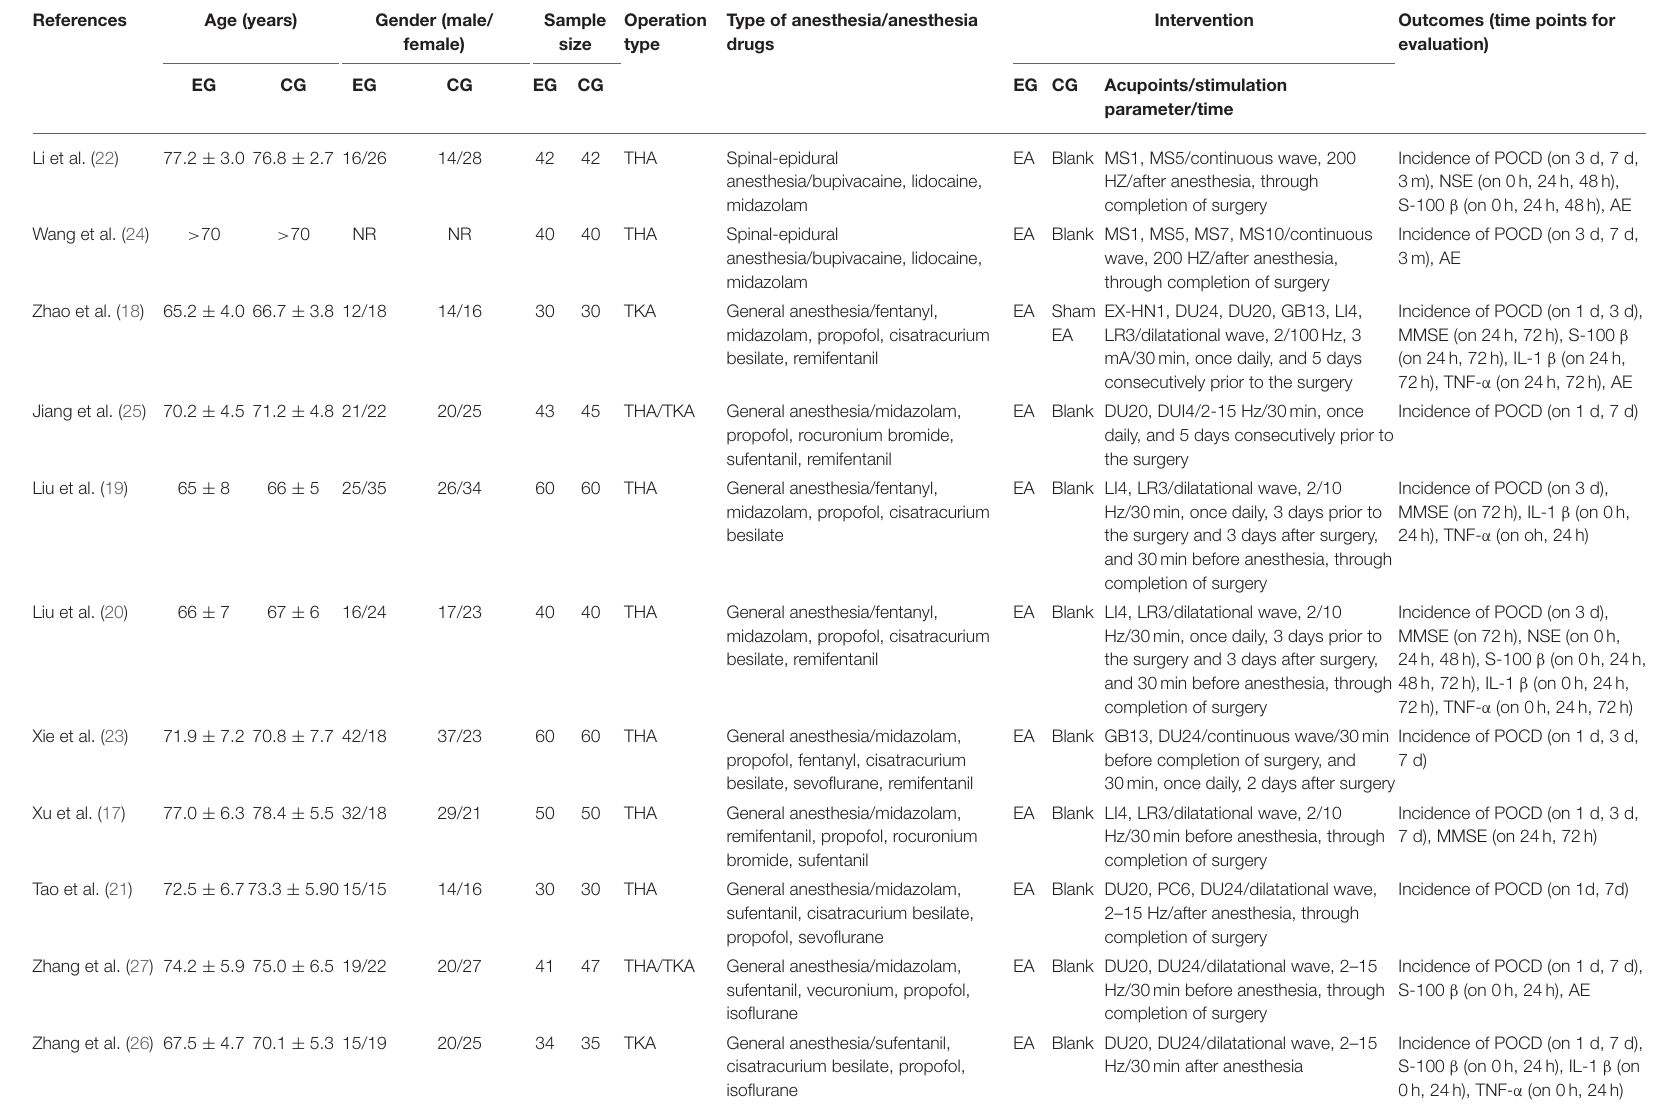
TABLE 1 | Characteristics of the included randomized clinical